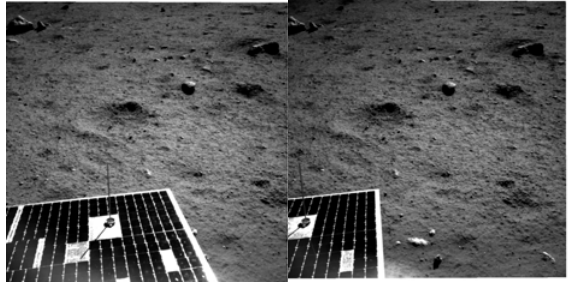
Figure 2. One pair of stereo images captured by the Yutu Lunar Rover’s Navcams at Site A